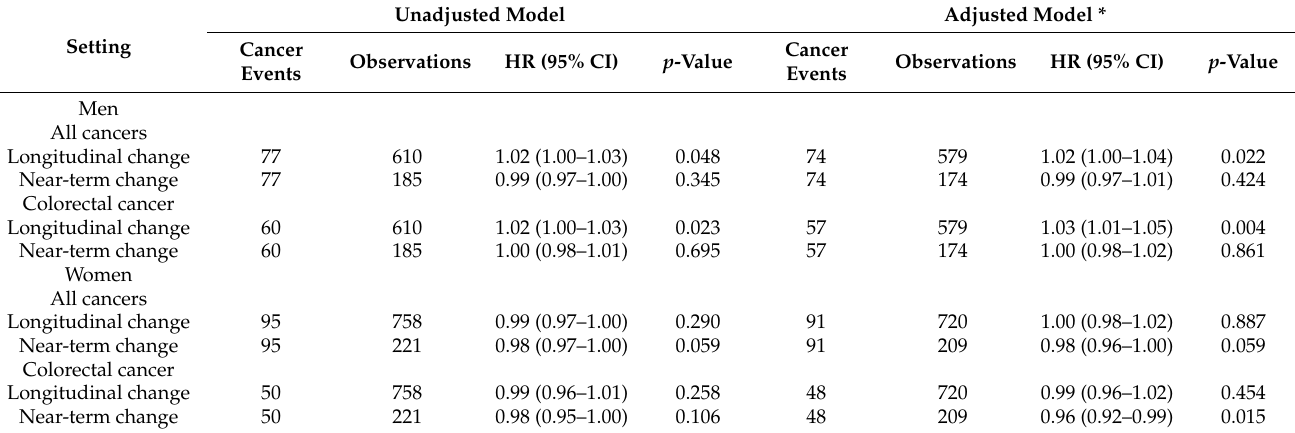
Table 4 presents the associations between adult life body weight and cancer risk. For consistency, all results in the text regarding body weight and cancer risk are presented only from models adjusted for height, MMR gene, education, alcohol consumption, smoking status, and the use of anti-inflammatory drugs. Table 4. Hazard ratios for associations of body weight and cancer risk in participants with Lynch